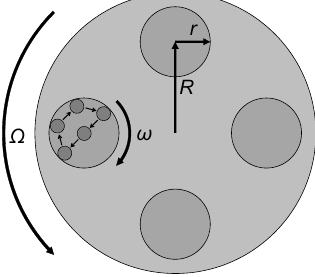
Figure 1. Representation of a planetary ball mill, equipped with four milling vials. Table 1. General summary of the milling parameters. Italic font indicates the variations examined